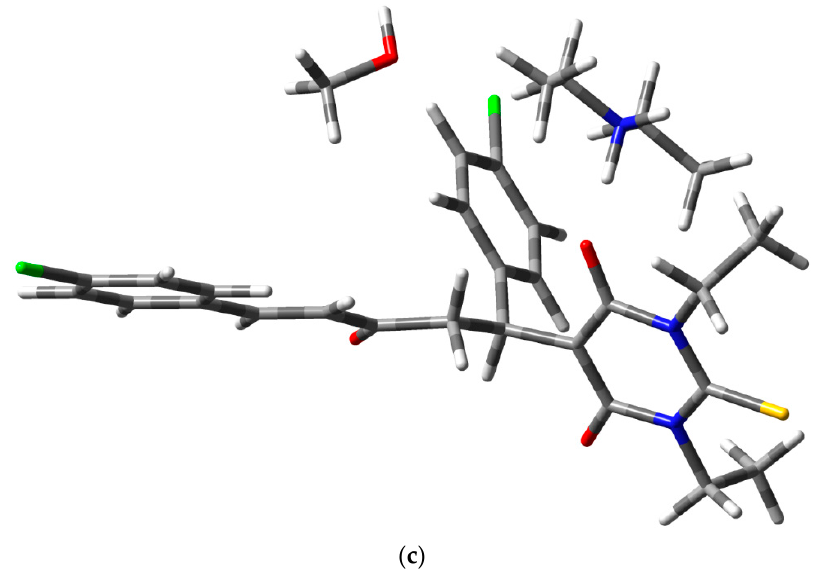
( c ) Figure 3. The calculated molecular structure of compounds 3a – c . Figure 3. The calculated molecular structure of compounds 3a – c . Table 4. The calculated and experimental structural data of the studied compounds using Table B3LYP/6-31G(d) method.